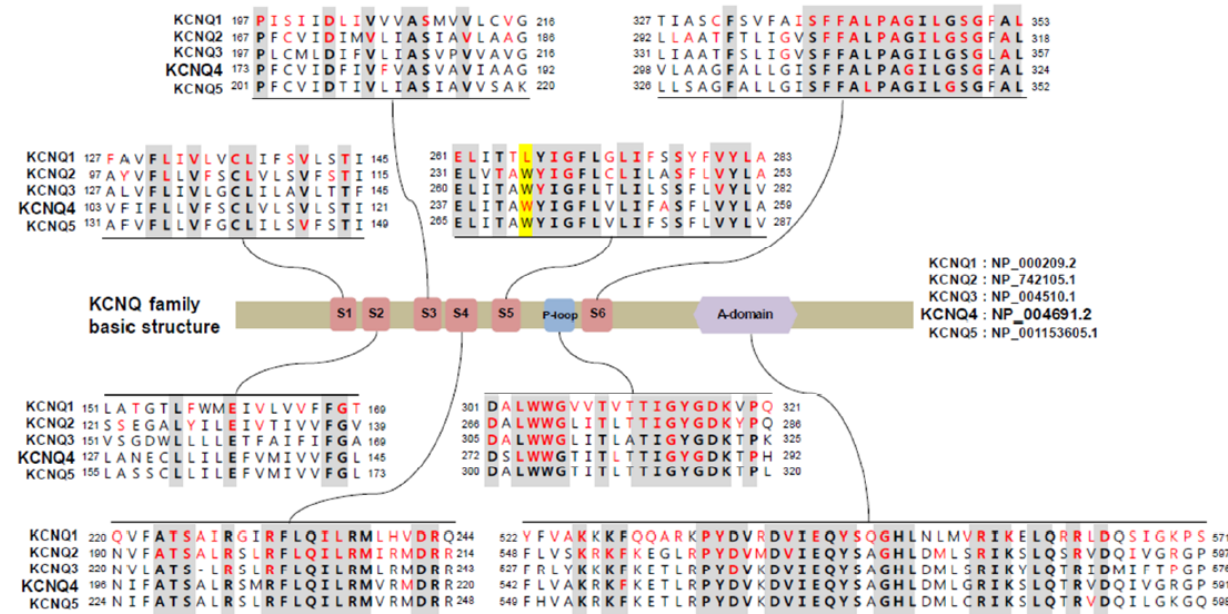
Figure 1. Comparative sequence analysis among voltage-gated channel subfamily q (KCNQ) family genes and mutational spectrum in protein sequences. Conserved sequences are presented in bold characters. Amino acids affected by pathogenic mutations reported in associated Mendelian diseases were collected from the HGMD and ClinVar databases and are presented in red characters. KCNQ2–4 share the tryptophan residue (Trp242 in KCNQ4, highlighted in yellow), which is critical for the activity of several KCNQ activators, including retigabine; however, KCNQ1 has a leucine at this position, and not a